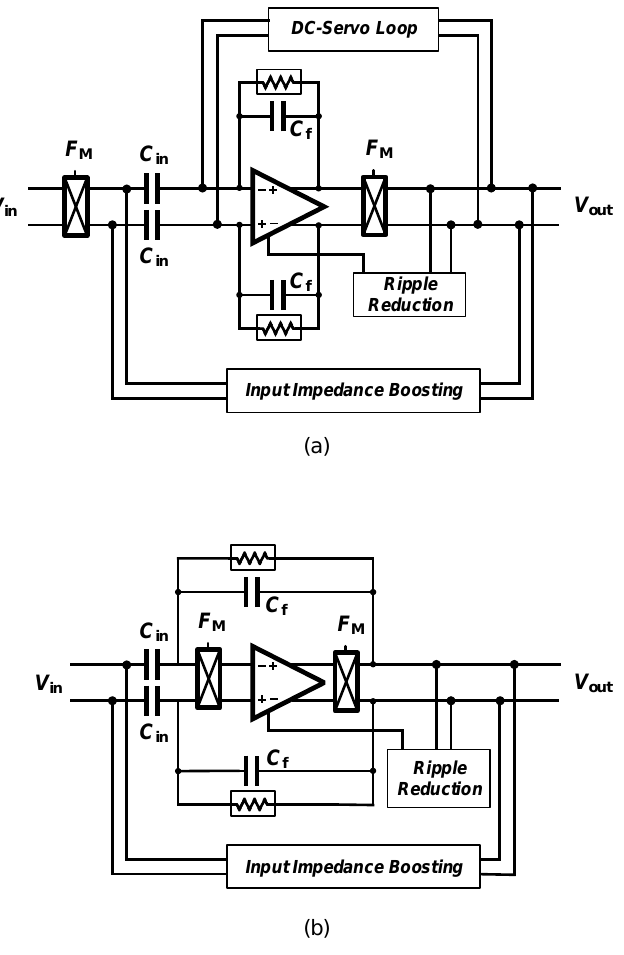
Figure 16. The ac-coupled chopper amplifier architectures. ( a ) Classical topology with servo loop and ( b ) alternated topology without servo